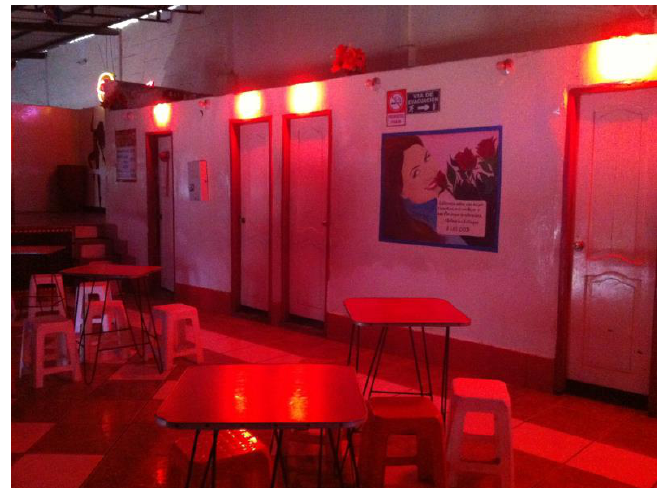
Figure 6. Brothel Las Rosas in Guayaquil, Ecuador. Photo by author.